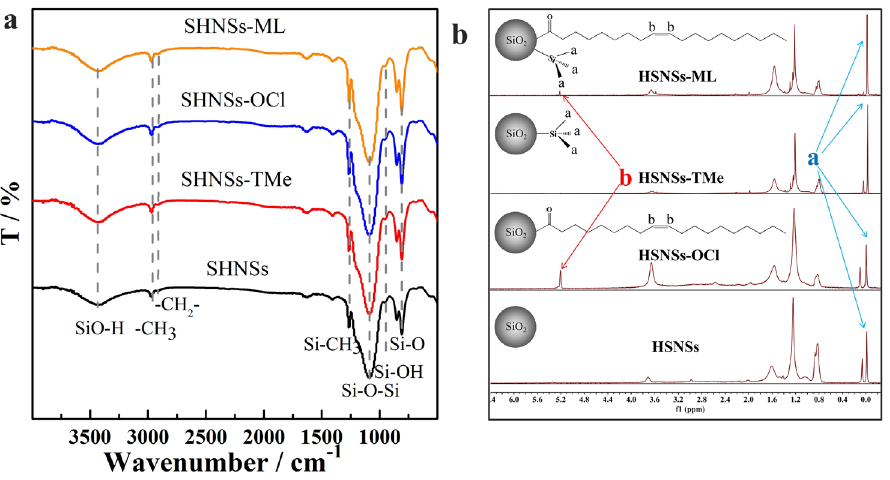
Figure 4. ( a ) FTIR spectra; ( b ) 1H NMR spectrum of CsPbBr 3 @HSNSs NPs and CsPbBr 3 @HSNSs-Grafted NPs.